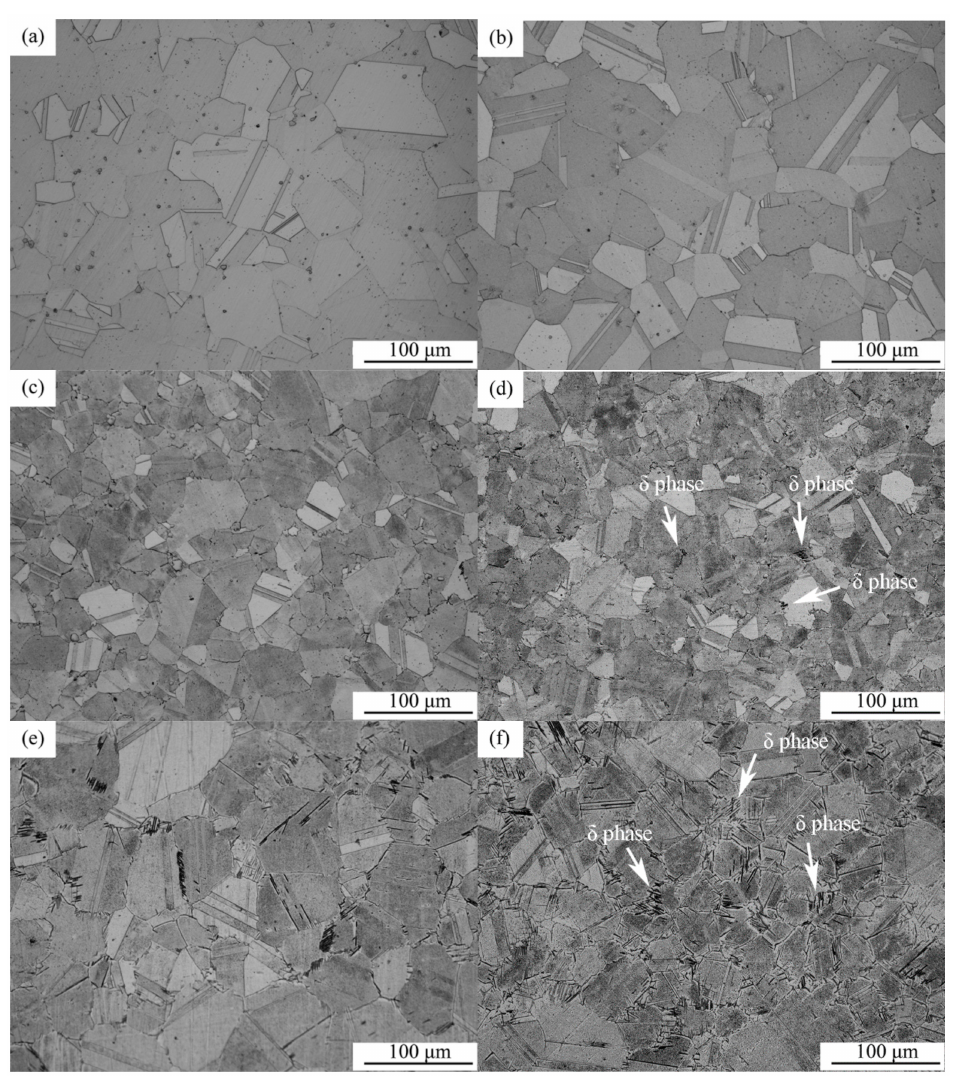
Figure 1. Optical microscopy (OM) images of GH4169 alloy after isothermal aging at ( a ) 800 ◦ C for 5 h; ( b ) 800 ◦ C for 11 h; ( c ) 850 ◦ C for 5 h; ( d ) 850 ◦ C for 11 h; ( e ) 900 ◦ C for 5 h; and ( f ) 900 ◦ C for 11